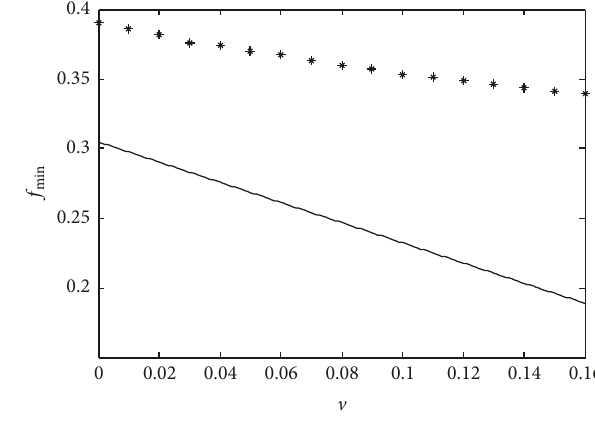
Figure 7: The relation curves of V and 𝑓 min .